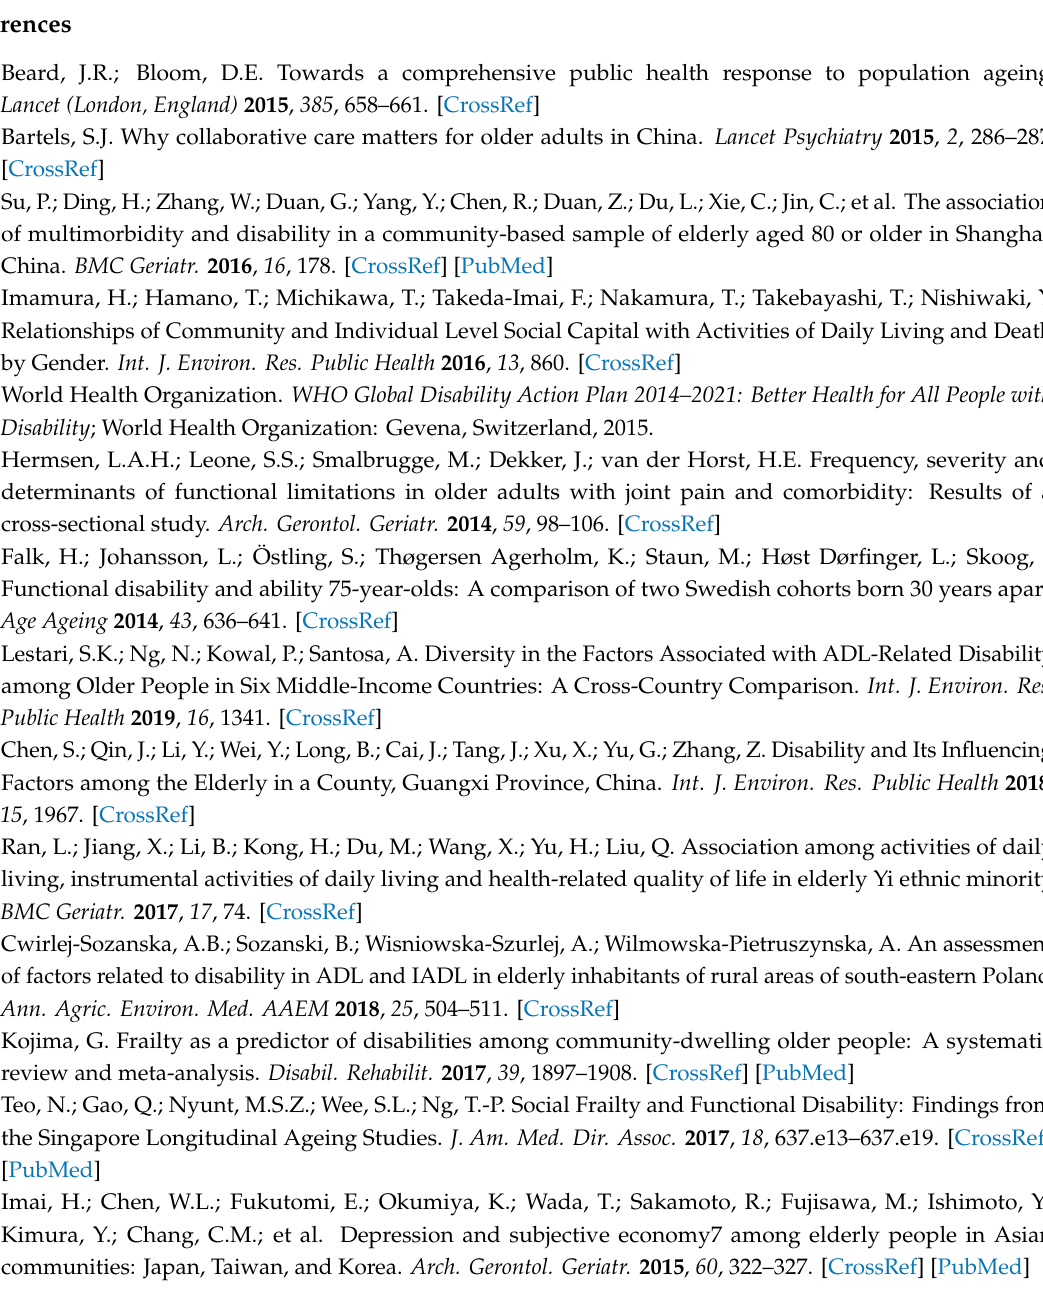
Table S1: Results of multicollinearity examination, Table S2: Correlations results between the